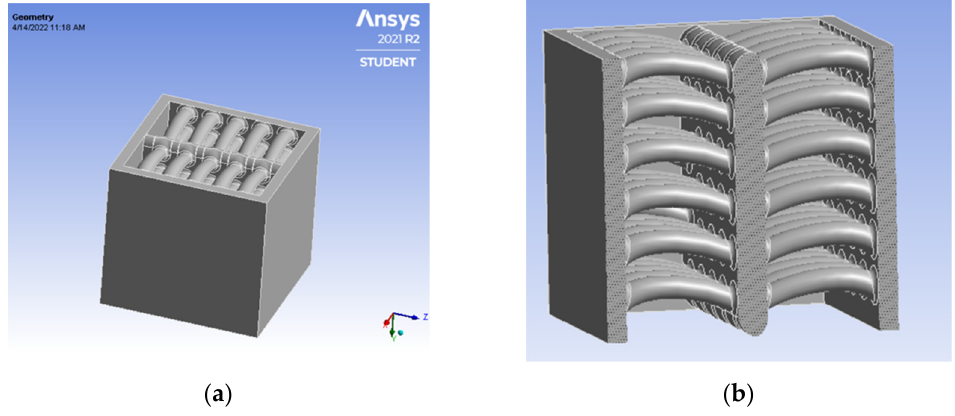
Figure 12. ( a ) Tortoiseshell isometric view; ( b ) Cross-sectional view.